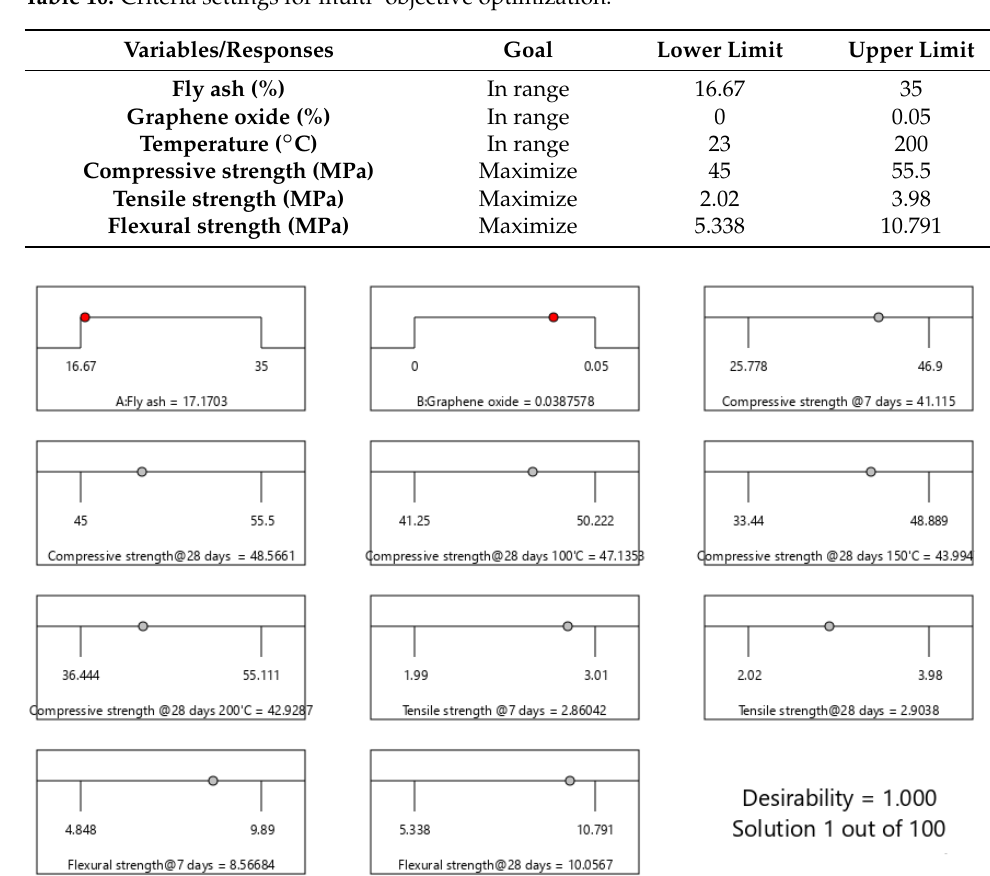
Table 10. Criteria settings for multi- objective optimization.